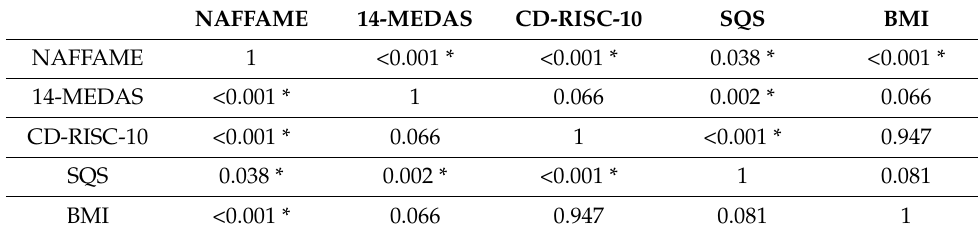
Table 2. p -values of the correlations between NAFFAME, 14-MEDAS, PsyR, sleep quality, and